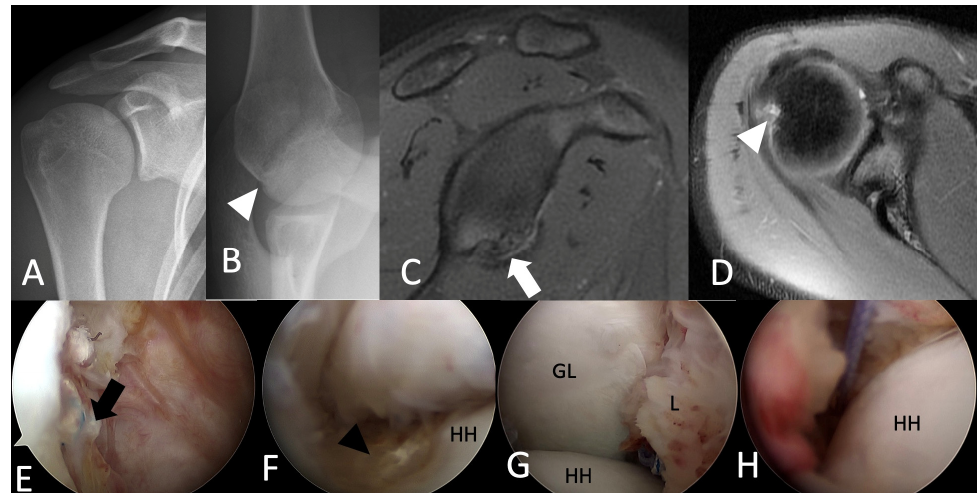
Figure 3. ( A , B ) Radiographs revealed a significant Hill–Sachs lesion (white arrowhead). ( C ) MRI revealed a recurrent ALPSA lesion (white arrow) and ( D ) a Hill–Sachs lesion (white arrowhead). ( E ) The previous suture was stable in place (black arrow), while anterior capsuloligament tissues were dislodged from sutures. ( F ) A Hill–Sachs lesion (black arrowhead). ( G ) A revision arthroscopic Bankart repair and a ( H ) Remplissage procedure were done. HH, humeral head. GL, glenoid; L, labrum.